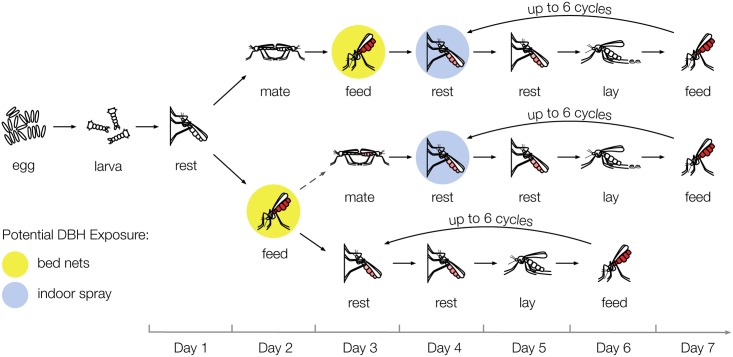
Schematic of mosquito life cycle model.Mosquitoes progress through the egg, larval, and pupal stages. Upon emergence, all mosquitoes rest outdoors for one day before mating first (50%) or feeding as virgins (50%). Some virgin feeders may subsequently mate, or, if exposed to and affected by DBH, may never mate. Afterwards, regardless of mating, all mosquitoes participate in up to 6 gonotrophic cycles, each cycle consisting of feeding (one day), resting indoors (two days), and ovipositing (one day). In our model, we assume that mosquitoes are exposed to DBH or insecticide only during their first feed (yellow circle) if applied via bed nets or only during their first indoor rest (blue circles) if applied via indoor spraying, and that mosquitoes exposed to DBH or insecticide via bed nets are nonetheless able to feed. Note that for indoor spraying, the bottom-most compartments are not used since in our model exposure always occurs after all mosquitoes have mated. In all gonotrophic cycles, DBH's effect on egg development reduces the number of eggs laid (no eggs are laid in the case of virgin mosquitoes). DBH also changes the age-dependent mortality starting on the day of first exposure and lasting throughout the mosquito's life. Insecticide increases mortality as well, but only on the day of exposure.